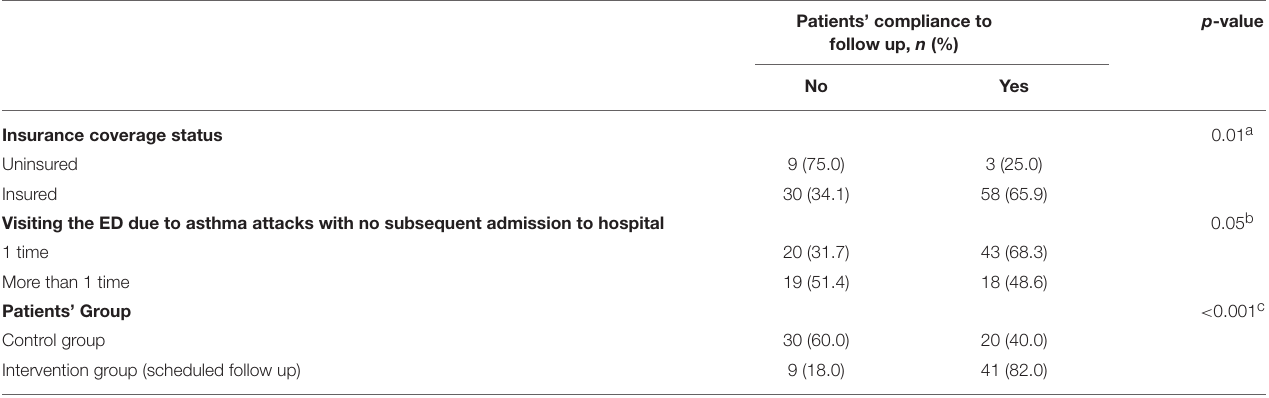
Patients’ compliance to follow up, n